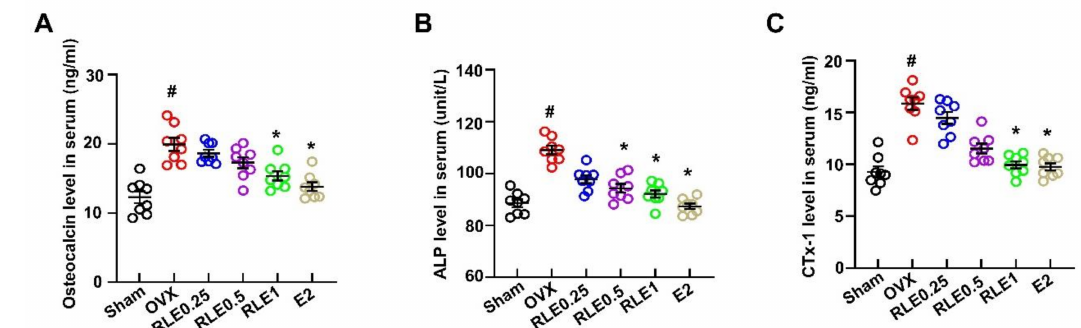
Figure 4. RLE regulates serum biochemical markers in OVX rats. ( A ) Osteocalcin, ( B ) ALP, and ( C ) CTx-1 expression levels in serum were analyzed by ELISA. Data are shown as mean ± SEM. ( n = 10, # p < 0.05 vs. sham; * p < 0.05 vs. OVX). Sham, sham-operated group; OVX, ovariectomy; RLE, Ramie leaf extract; E2, 17 β -estradiol; CTx-1, β -C-terminal telopeptide of type 1 collagen; ALP, alkaline